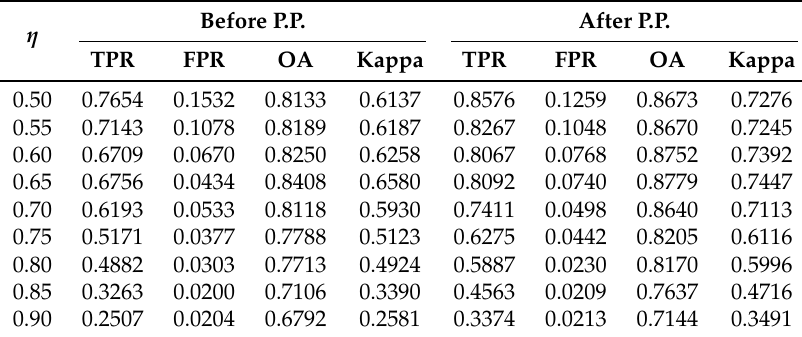
Table 2. Performances of the proposed method before and after post-processing for different η when n = 21 using the Google Earth